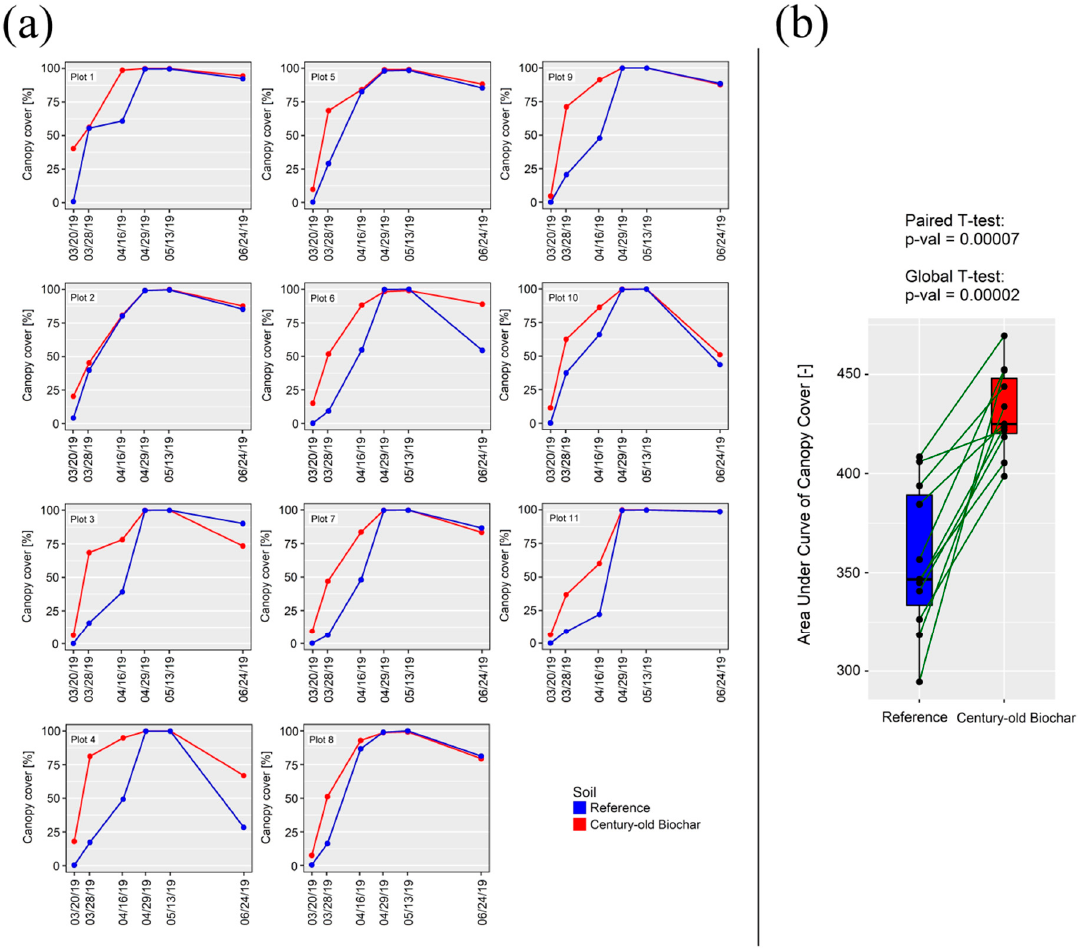
Figure 4. ( a ) Temporal profiles of the canopy cover, derived from the RGB imagery, comparing the 11 century-old biochar plots with the corresponding reference plots throughout the season. ( b ) Box plot visualization of the area under the curve of canopy cover between the century-old biochar and reference plots (i.e., obtained from graphs displayed in sub-plot a for each site). The horizontal black line displays the median value, surrounded by box edges representing the 25th and 75th percentiles. The black circles show all of the experimental plots and the grey dark green line indicates the corresponding pairs of a reference and century-old biochar plot.